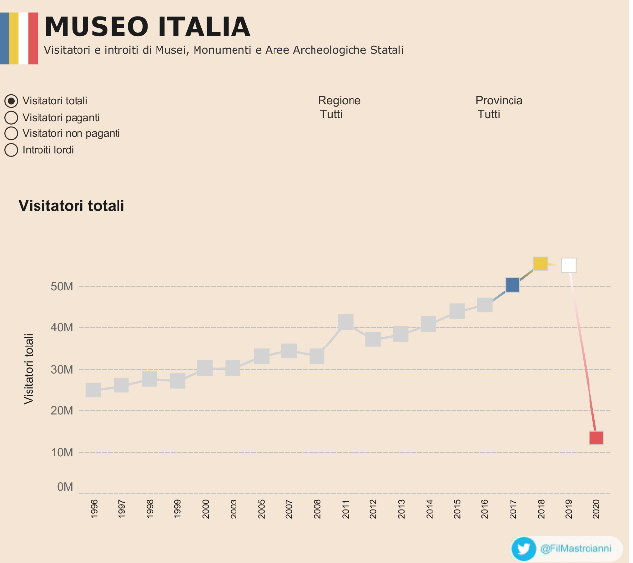
Figure 1. Visitors and income from state museums, monuments, and archaeological sites. Source: Il Sole 24 Ore [3].